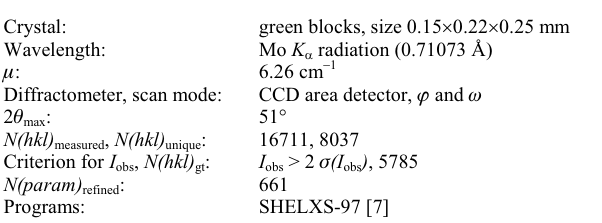
Table 1. Data collection and handling.